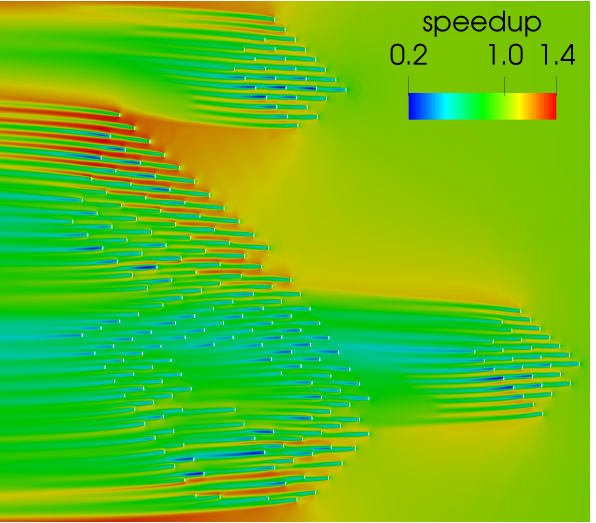
Figure 16. Final computed speedup for the adaptive simulation process for a set of four wind farms on the North Sea (219